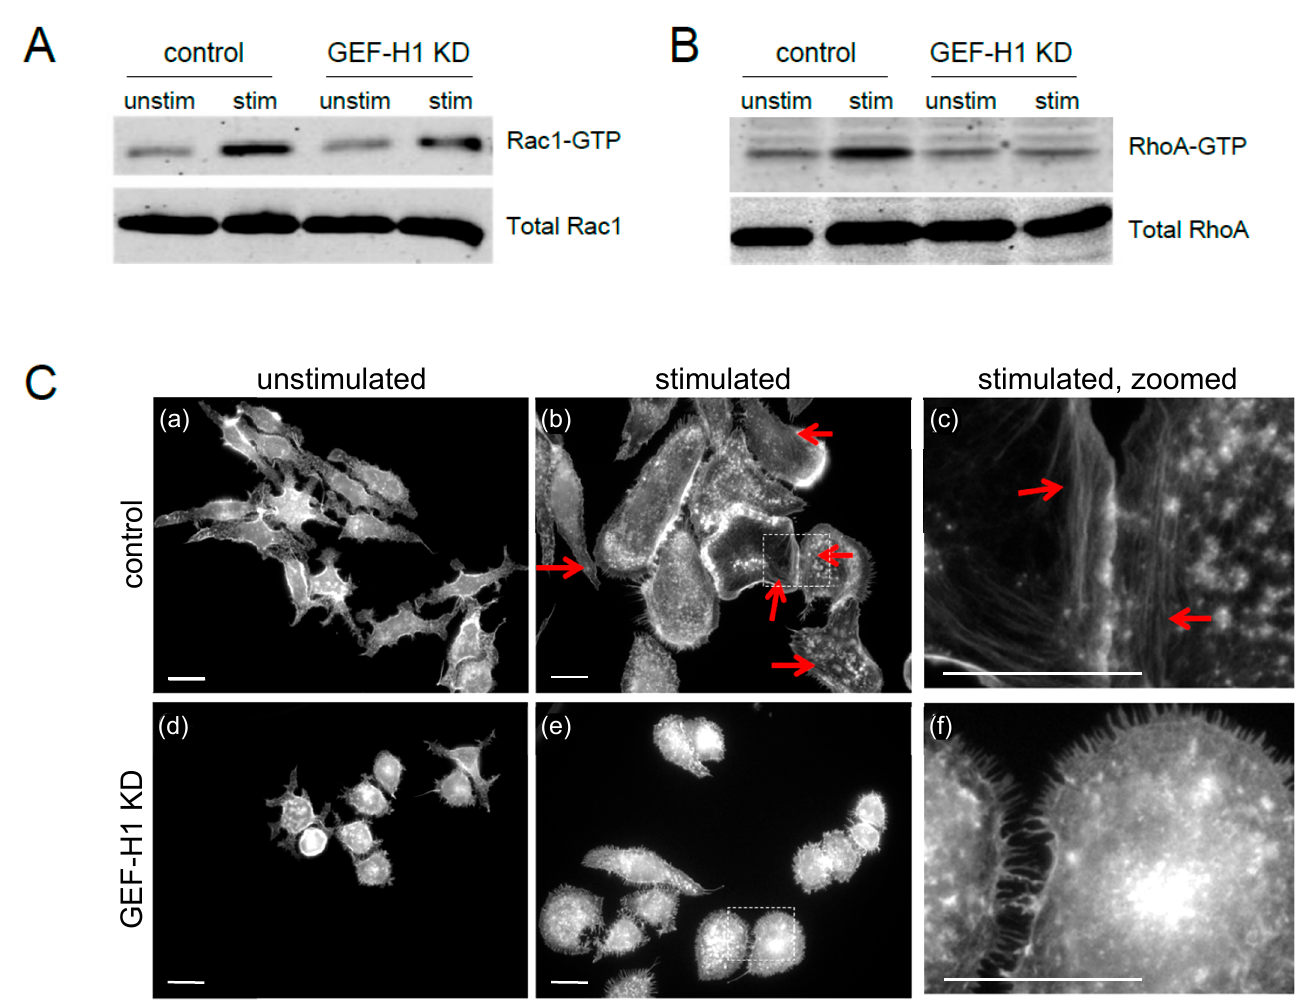
Figure 5. RhoA, but not Rac1, is a downstream effector of GEF-H1 in antigen-stimulated RBL-2H3 cells. Detection of activated Rac1 ( A ) and RhoA ( B ) was performed by pulldown assays using Rhotekin or PAK1 probes that bind RhoA-GTP and Rac1-GTP, respectively. Active levels of both RhoA and Rac1 increased in control cells after 20 min of antigen stimulation (control, stim). Depletion of GEF-H1 did not affect Rac1-GTP levels, but resulted in reduced RhoA-GTP levels (GEF-H1 KD, stim). ( C ) Depletion of GEF-H1 affected the formation of stress fibers. Alexa Fluor 405-phalloidin was used to label F-actin structures in unstimulated cells ( left panels ) and after 20 min of antigen stimulation ( middle panels ). Control cells showed the formation of stress fibers that project to the plasma membrane ( panels b and c , red arrow ). GEF-H1-depleted cells lacked stress fiber formation and showed reduced cell spreading ( panels e and f ). Scale bar = 20 µm.